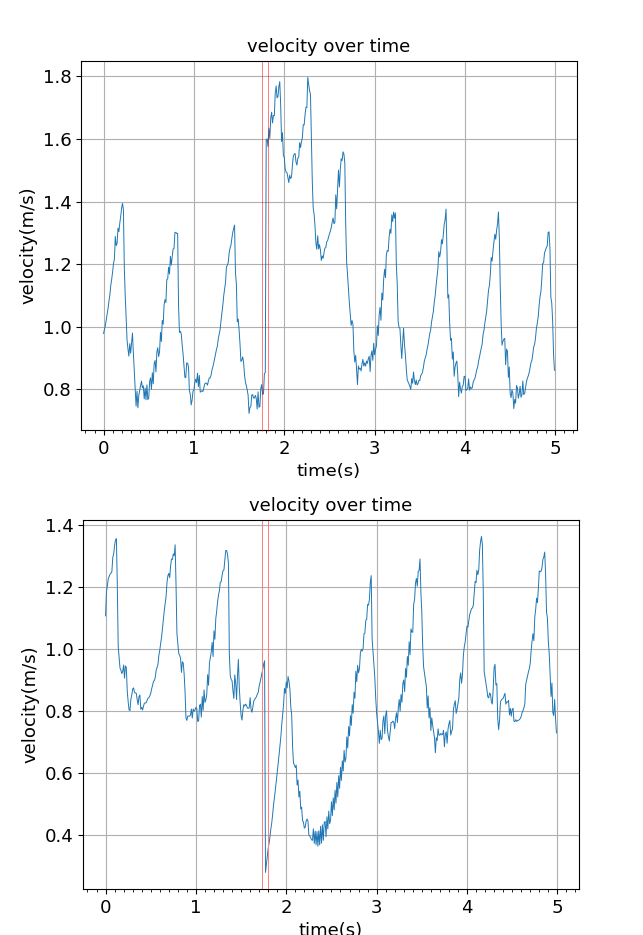
Figure 9. Impact of outside disturbances on the walking speed. Walking speed vs. time is plotted. ( top ) A 30 kg · m/s impulse is applied to the torso in the walking direction. ( bottom ) A 40 kg · m/s impulse is applied to the torso opposite to the walking direction.